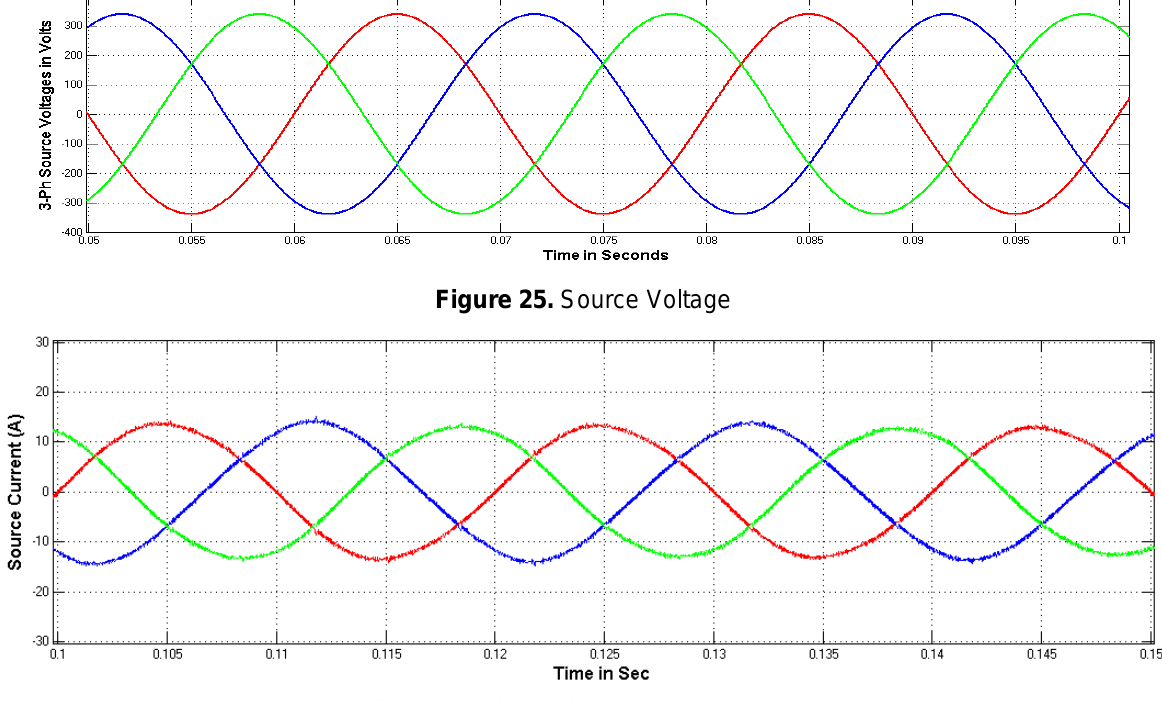
Figure 26. Three-phase source Currents